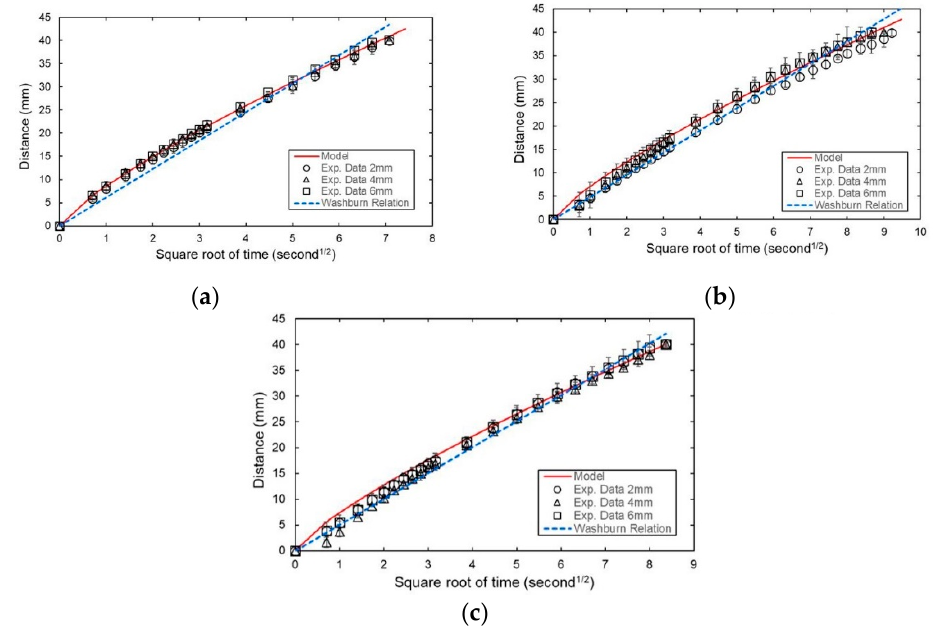
Figure 6. Comparison between our model and experiment data ( a ) non-laminated CFSP, ( b ) one-side laminated CFSP and ( c ) two-side laminated CFSP.